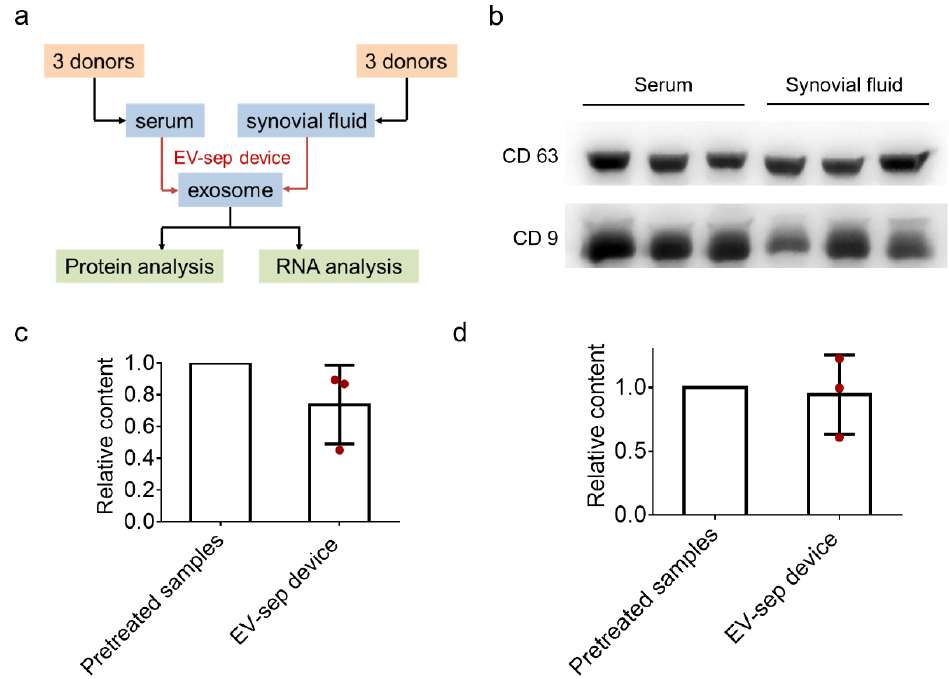
Figure 3. Characterization of protein markers and the RNA content of the obtained exosomes separated by the exosome separation device from serum and synovial fluid. ( a ) A general workflow developed for conducting serum and synovial fluid exosome isolation using the exosome separation device, followed by protein and RNA analysis. ( b ) Expression of CD9 and CD63 in exosomes separated from serum and synovial fluid. ( c , d ) The relative content of total RNA in exosomes from serum ( c ) and synovial fluid ( d ) isolated using the exosome separation device (EV-sep device). The results were normalized to the corresponding pretreated samples. The data are presented as the mean ± SD, n =